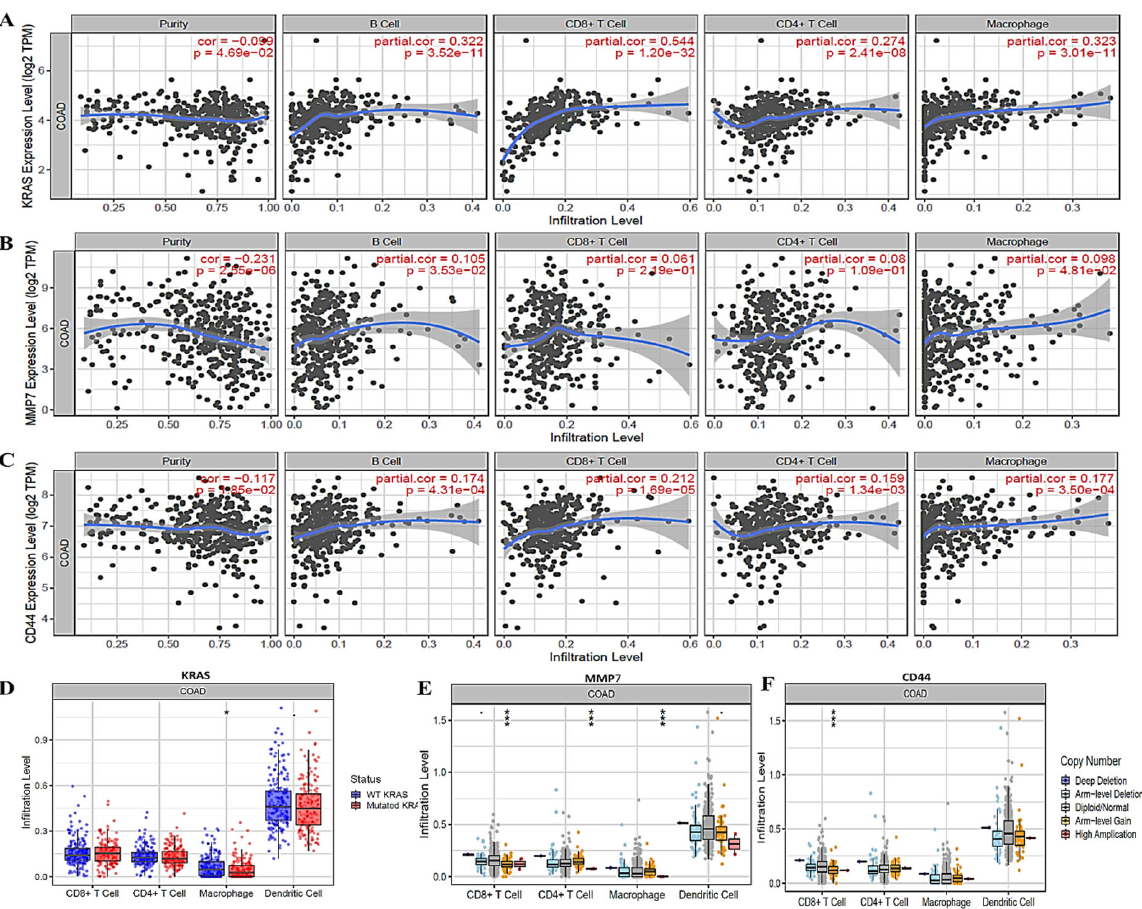
Figure 8. KRAS/MMP7/CD44 expressions correlated with immune infiltrating cells in (COAD). ( A ) KRAS , ( B ) MMP7 , and ( C ) CD44 expression levels displayed associations with tumor purity and were positively correlated with infiltrating levels of B cells, CD8+ T cells, CD4+ cells and M2 macrophages, ( D ) KRAS , ( E ) MMP7 , and ( F ) CD44 expressions were correlated with abundances of tumor infiltrates including CD8+ T cells, CD4+ T cells, macrophages, and dendritic cells in CRC. Red represents considerable positive correlations with high amplification, while blue represents negative correlations. The infiltration level was compared to the normal level using a two ‐ sided Wilcoxon rank ‐ sum test. p ‐ value Significant Codes: 0 ≤ *** p < 0.001 ≤ ** p < 0.01 ≤ * p < 0.05 ≤ p < 0.1.